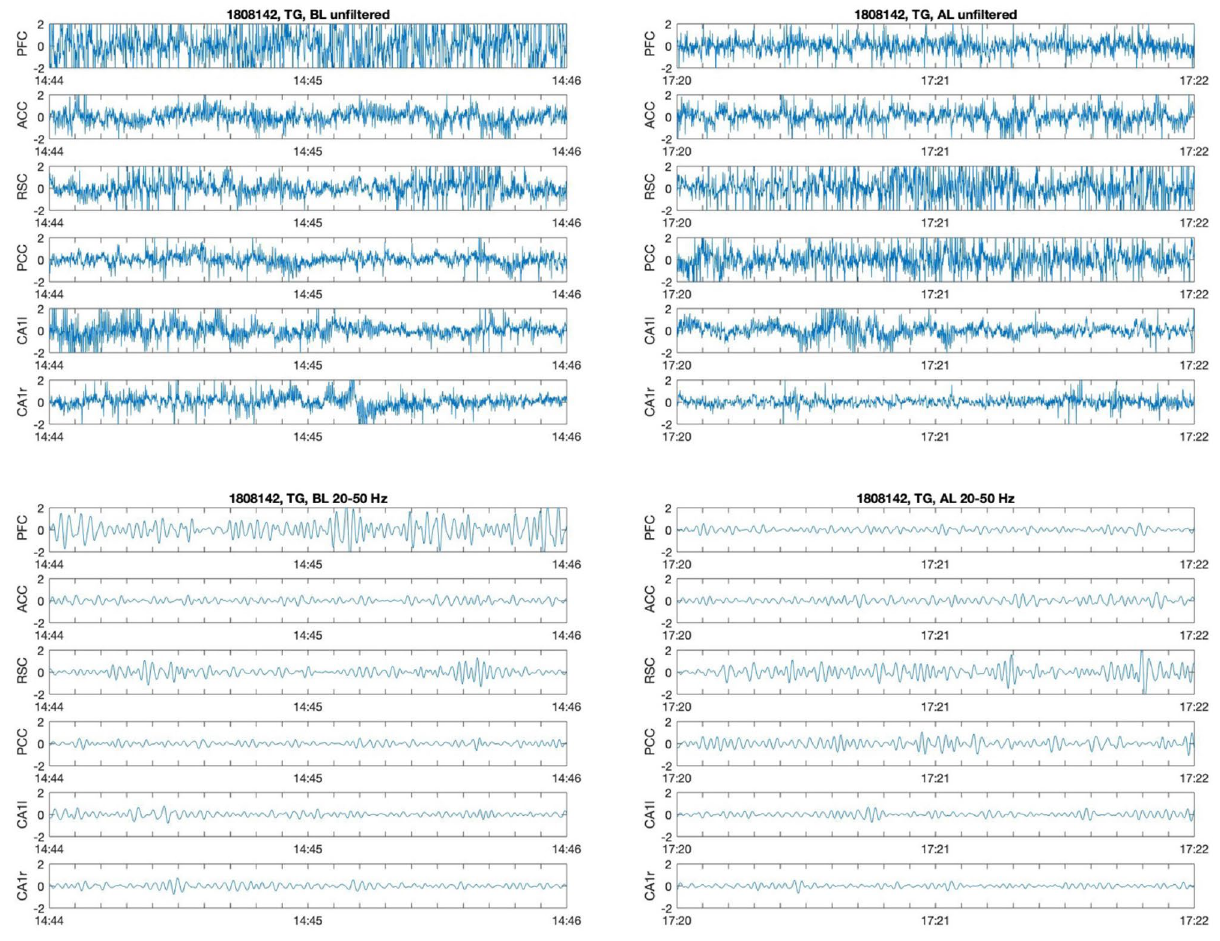
Figure 9. Examples of recorded LFP signals for TG mouse before (left column) and after learning (right column). Two-seconds long epochs selected from SWS recordings are shown. Upper pictures—unfiltered signals, sampled at 500 Hz. Lower pictures—the same signals filtered in slow gamma range (20–50 Hz). Horizontal scale shows time from the beginning of the recording in min:s